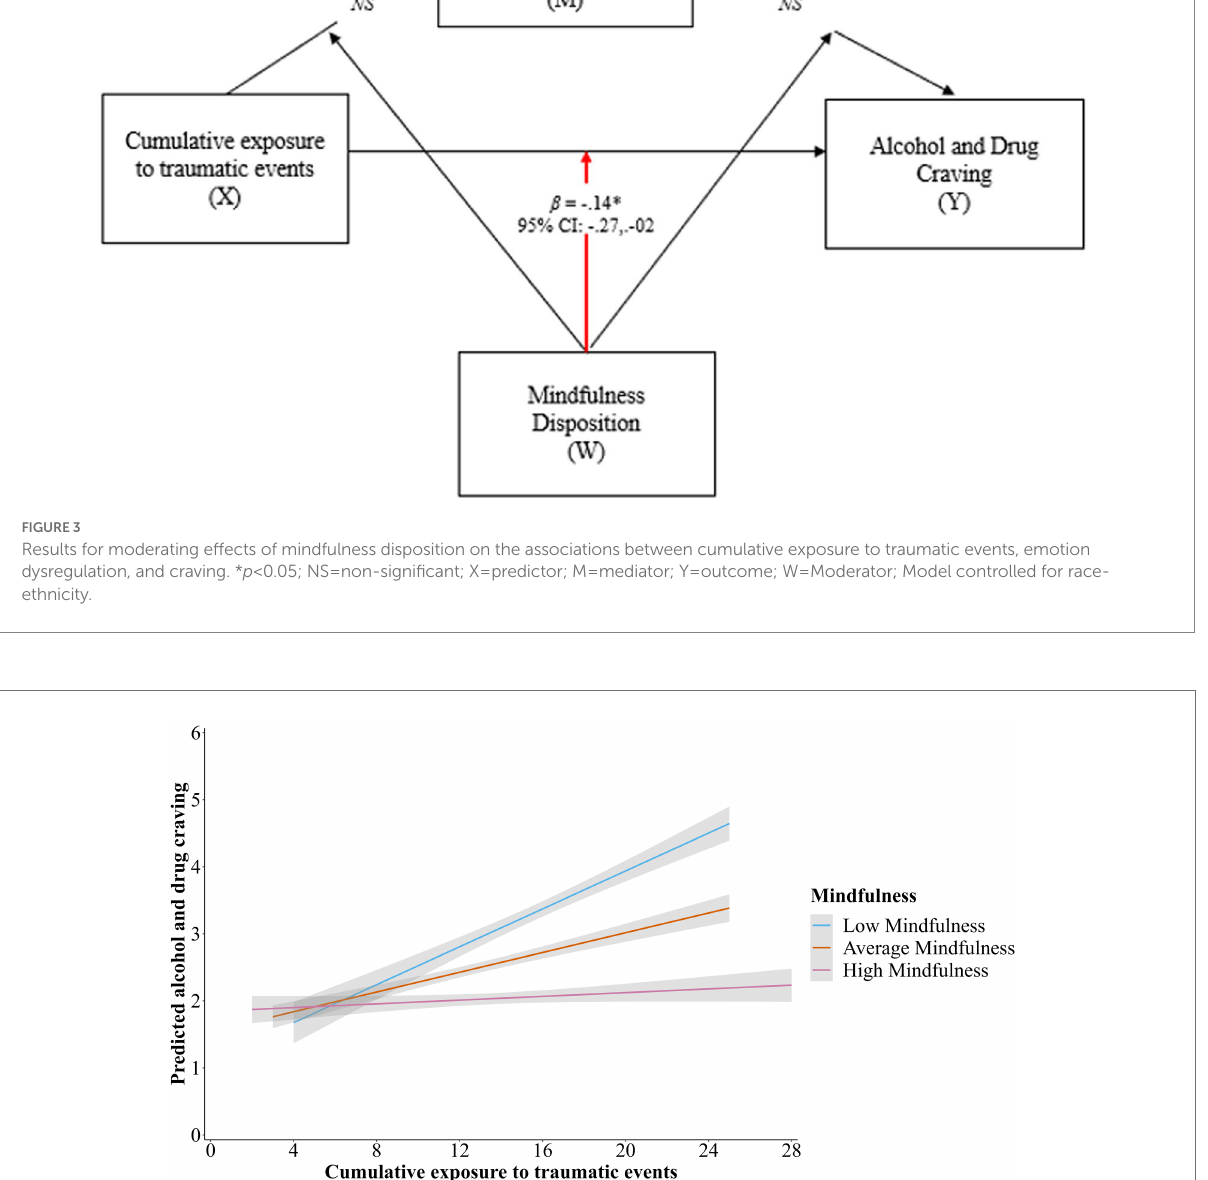
FIGURE 4 Two-way interaction with mindfulness disposition moderating the association between cumulative exposure to traumatic events and